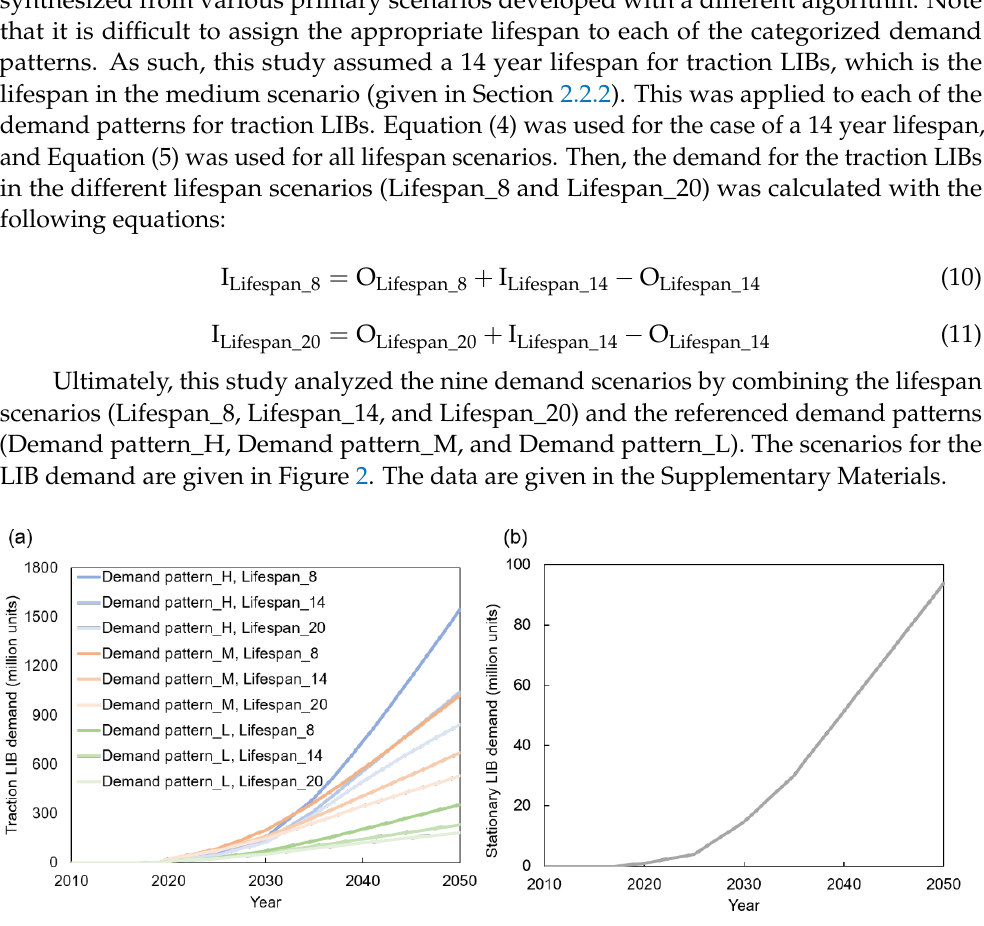
Figure 2. Scenarios of LIB demand for ( a ) traction and ( b ) stationary use.